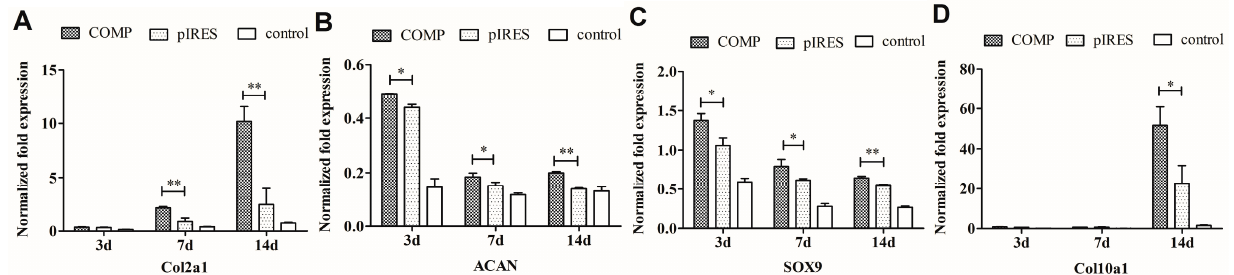
Figure 8. The relative mRNA expression of ( A ) collagen type II alpha 1 ( Col2 α 1 ); ( B ) aggrecan ( ACAN ); ( C ) sry-related high-mobilitygroup box 9 ( SOX9 ) and ( D ) collagen type X alpha 1 ( Col10 α 1 ) were analyzed by real-time PCR. The value was normalized to GAPDH ( n = 3,* p < 0.05, ** p <